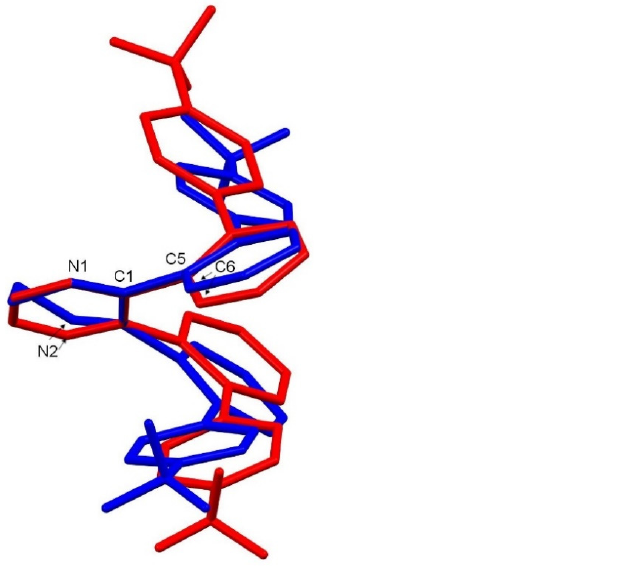
Figure 3. Superposition showing the difference in torsion angle N1–C1–C5–C6 5b (blue) and 6b (red). Disorder on CF 3 groups is omitted for clarity.